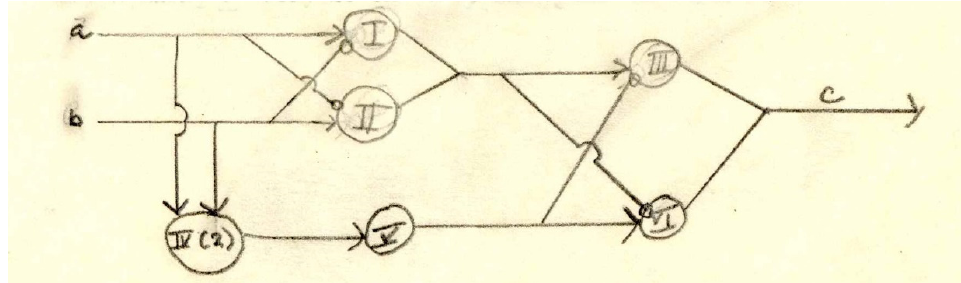
Figure 3. This logic diagram from von Neumann’s Lecture 3 (Figure 7 of the lecture) shows a binary adder. The numbered circles are neurons; small circles represent inhibitory inputs into the neurons; and arrowheads represent stimulating (i.e., energizing) inputs into the neurons. ‘a’ and ‘b’ represent the two bits that are to be added. With the exception of neuron IV, the threshold of each neuron is 1; neuron IV’s threshold is shown as 2. In fact the diagram is not quite accurate: von Neumann explained clearly in the lecture that neuron IV is supposed to obtain ‘one input from itself’; but whoever drew the diagram omitted the essential arc from IV back to IV. Courtesy of the American Philosophical